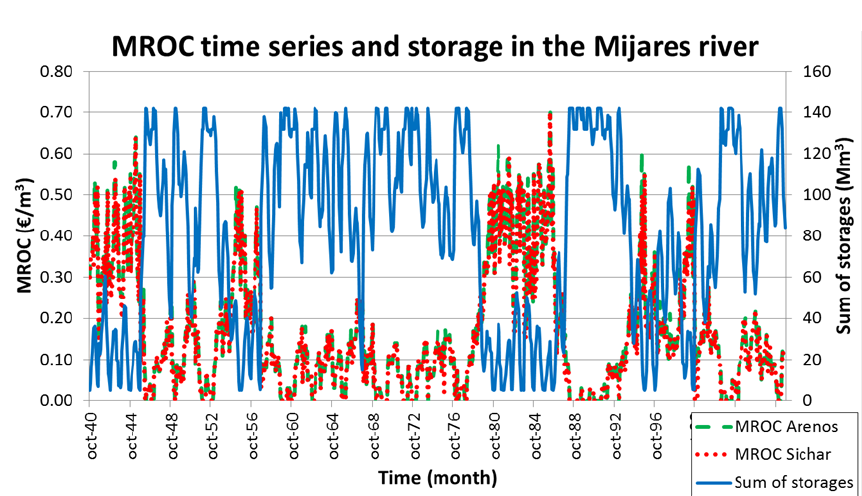
Figure 5. MROC time series and storages in the Mijares